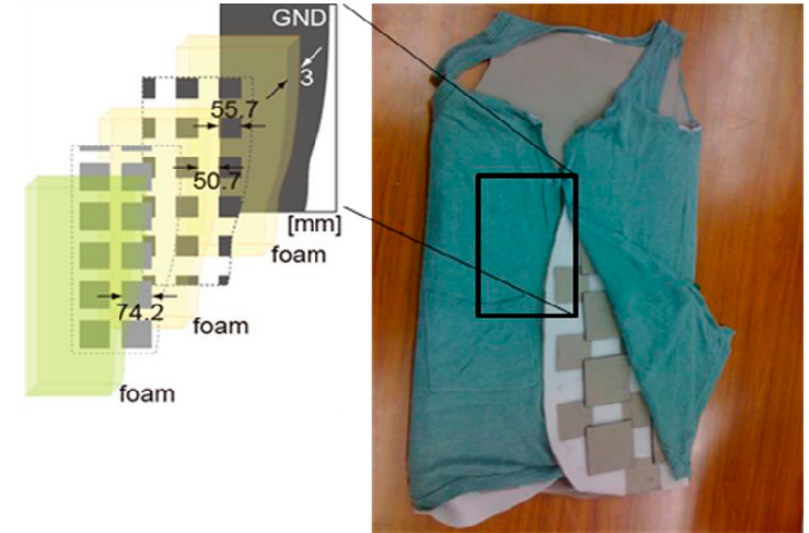
Figure 9. A vest equipped with a flexible transmission line.